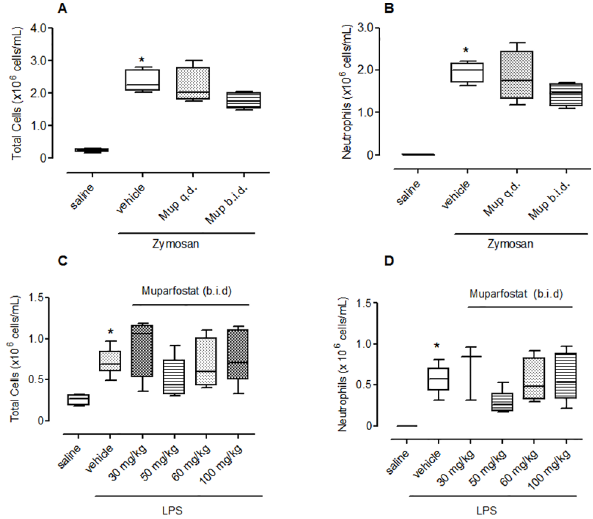
Fig 3. The effect of pharmacological treatment with the heparanase inhibitor Muparfostat on neutrophil recruitment to the lung. The total number of inflammatory cells (A, C) and neutrophils (B, D) recruited to the lung following acute exposure to zymosan (A, B) or LPS (C, D). Wild-type (WT), and Hpa -/- mice received intranasal (i.n.) saline, zymosan (A, B) or LPS (C, D). The number of total cells (A) and neutrophils (B) in bronchoalveolar lavage fluid 24 h after intranasal administration of zymosan in BALB/c mice treated with Muparfostat (30 mg/kg s.c.) dosed 30 minutes before (q.d.) and 6 h after (b.i.d) zymosan exposure, n = 4 per group. Data presented as box plots (median, 25 – 75 percentile) with whiskers representing 5 – 95% confidence interval. * p < 0.05 compared with saline. Data obtained from one experiment. In other experiments total number of cells (C) and neutrophil (D) recruitment to the lung was measured following intranasal administration of LPS in vehicle and Muparfostat (b.i.d.) treated mice (n = 3 – 9). Data presented as box plots (median, 25 – 75 percentile) with whiskers representing 5 – 95% confidence interval. * p < 0.05 compared with saline. Treatment groups were not significantly different from vehicle (symbol not reported). Data was obtained from two independent experiments.